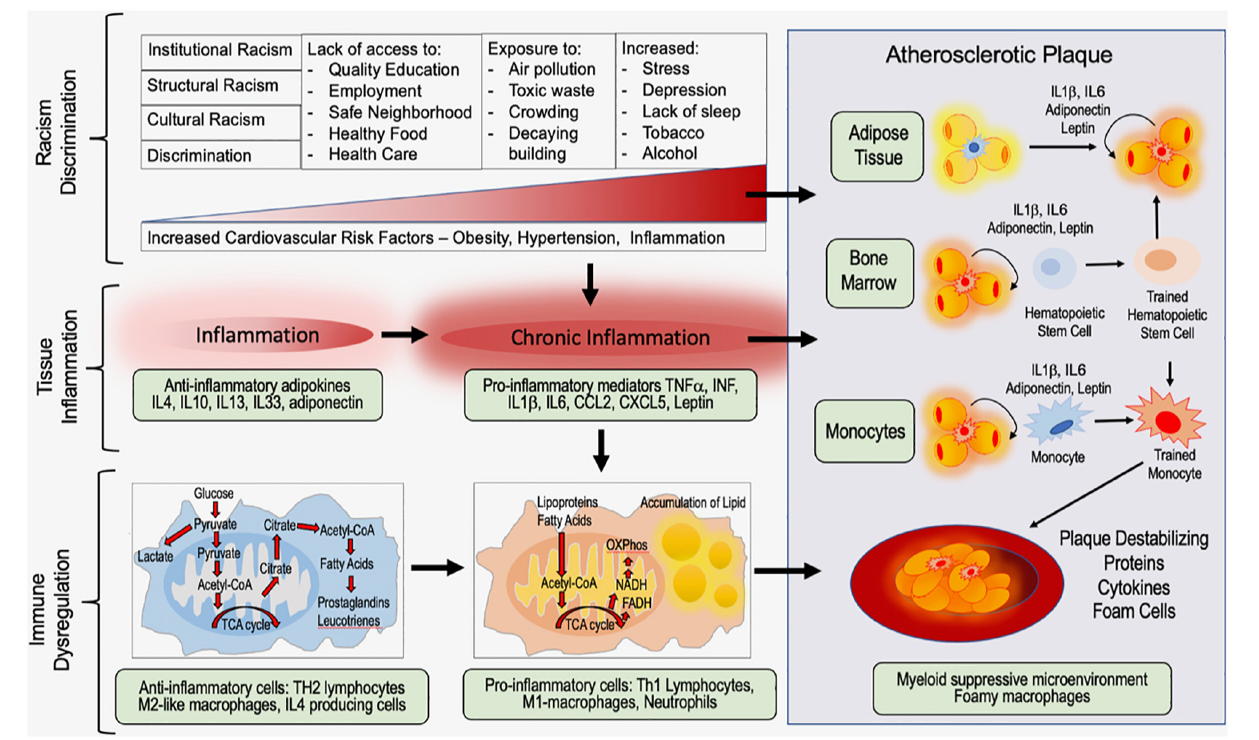
FIGURE 3 | Working model of the impact of racism and discrimination on tissue inflammation, immune dysregulation, and atherosclerotic plaque